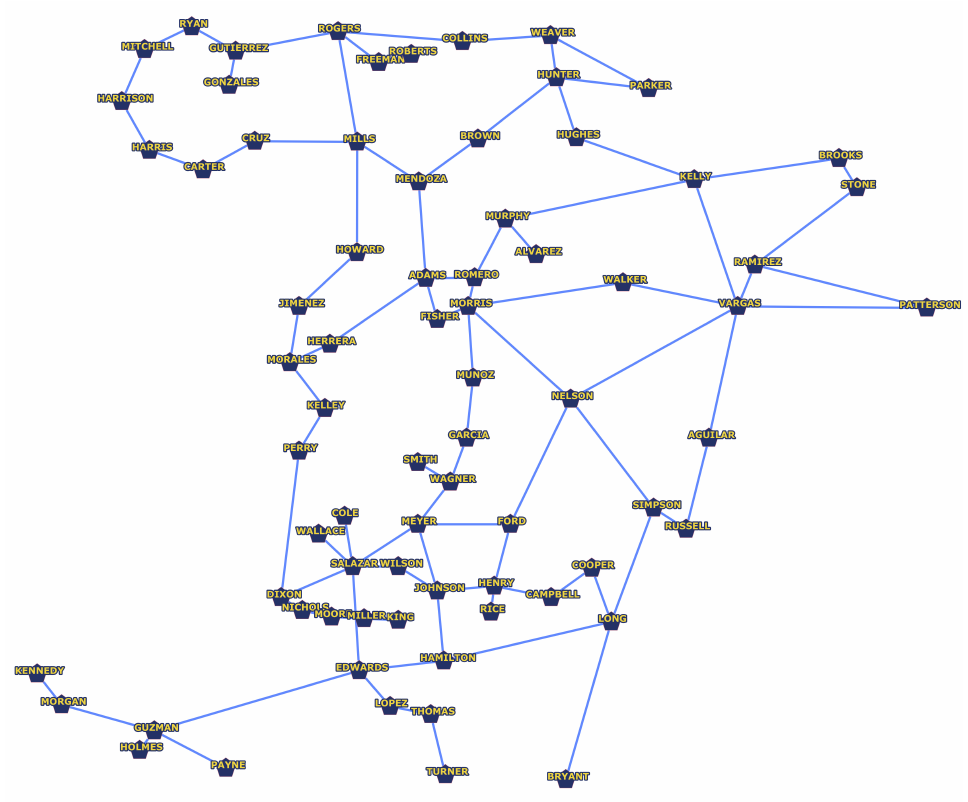
Figure 2. General schematic diagram of the network of quantum repeaters.